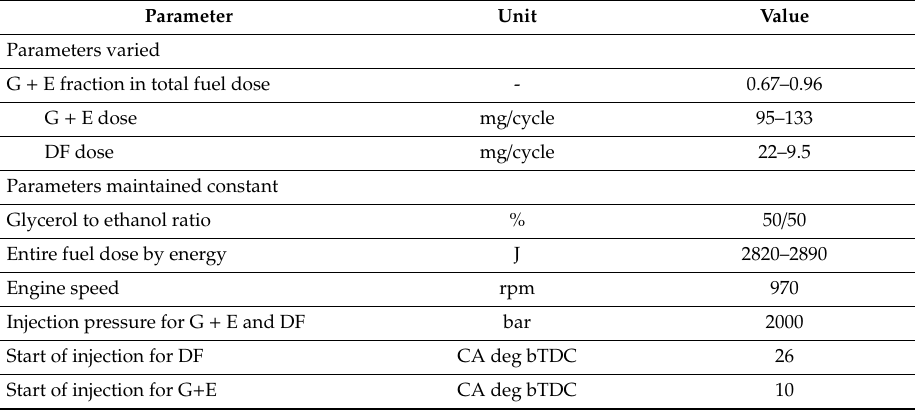
Table 4. Test matrix.